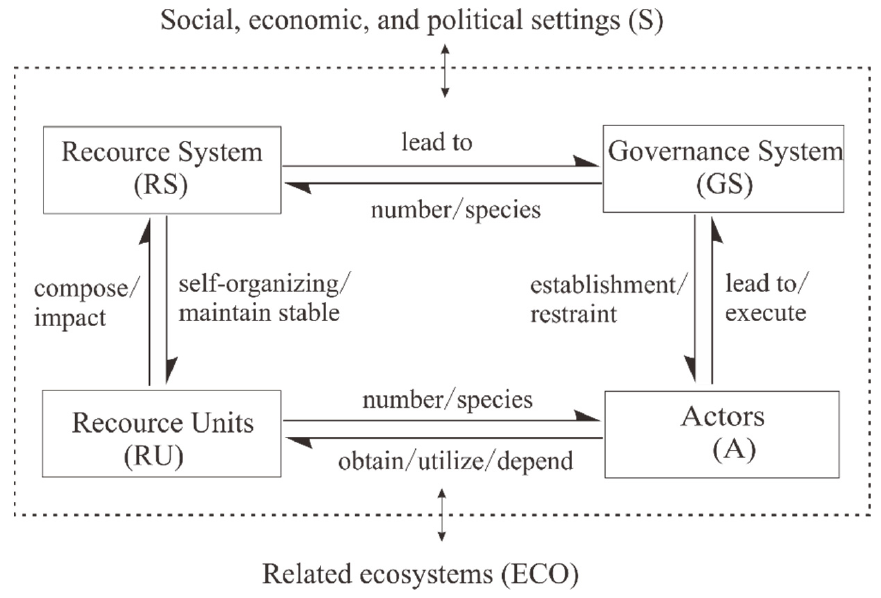
Figure 6. SES adaptability mechanism of residents (Ostrom, 2009, [47]).